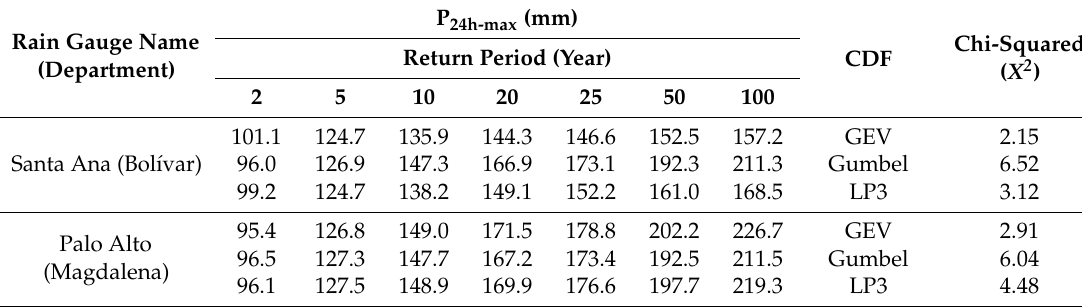
Table 6. P 24-max values for different return